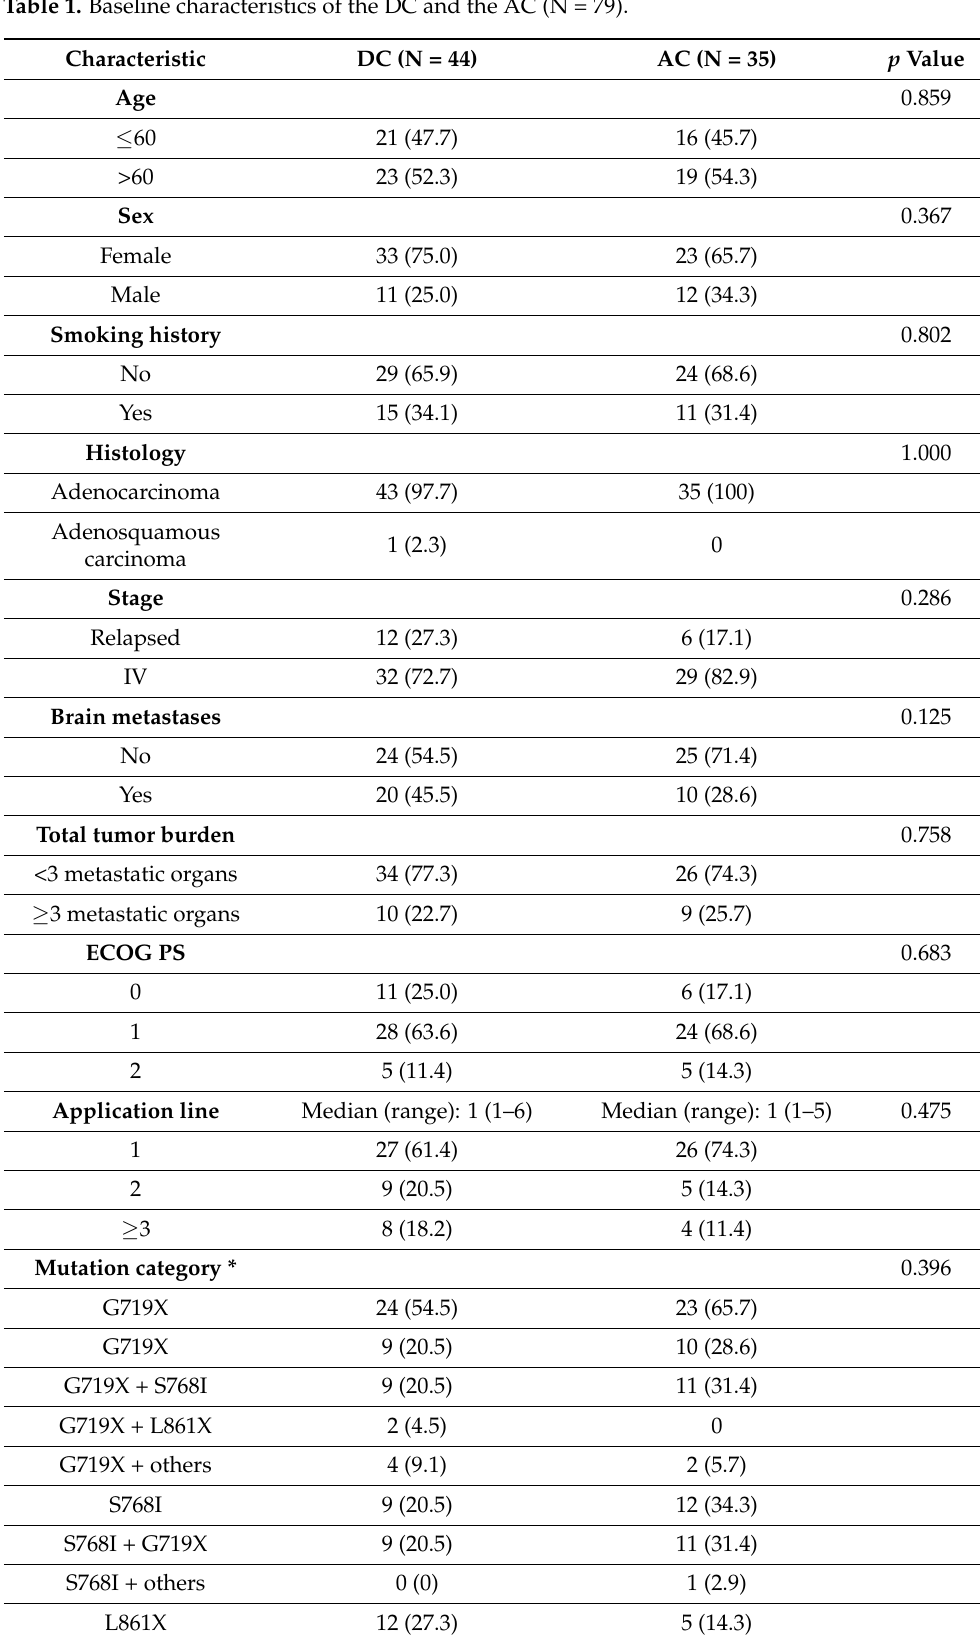
Table 1. Baseline characteristics of the DC and the AC (N =